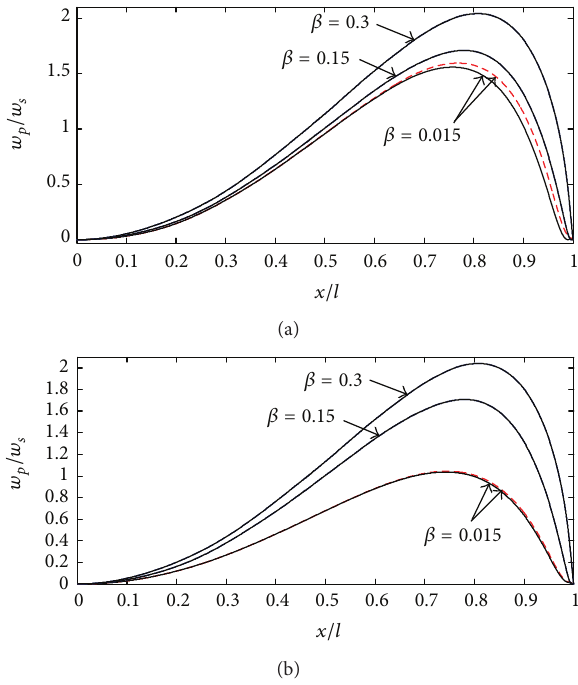
Figure 9: Variation of dimensionless instantaneous dynamic lateral deflection, 𝑤 𝑝 /𝑤 𝑠 , versus normalized instantaneous position of moving mass, 𝑥/𝑙 , of the Timoshenko beam with 𝑚 = 5𝜌𝐴𝑙 kg and 𝛼 = 0.25 and different 𝛽 values. (a) 𝑘 1 = 𝑘 3 = 𝑐 = 0 , (b) = 10 4 N/m 2 , 𝑘 = 10 4 N/m 4 , and 𝑐 = 10 3 N ⋅ s/m 2 ; (- - - - -) M-1 𝑘 1 3 model and (—) M-2 or M-3